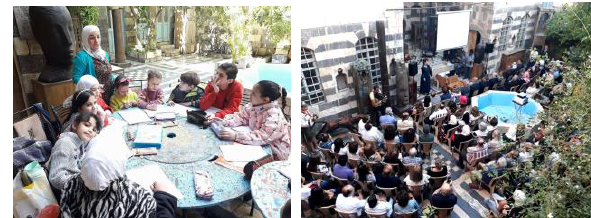
Figure 16. Varied activities in 2018 (left) and in 2019 (right), Mustafa Ali Gallery